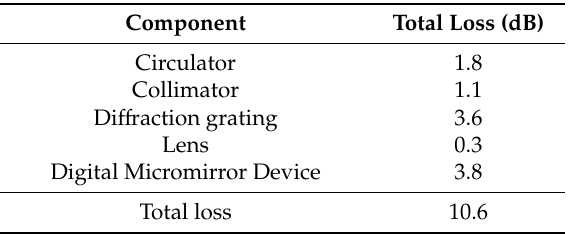
Figure 4. Tunable wavelength ( a ) and bandwidth ( b ) of a DMD filter. Table 2. Loss from components used in TDFL in 2 μ m-band.